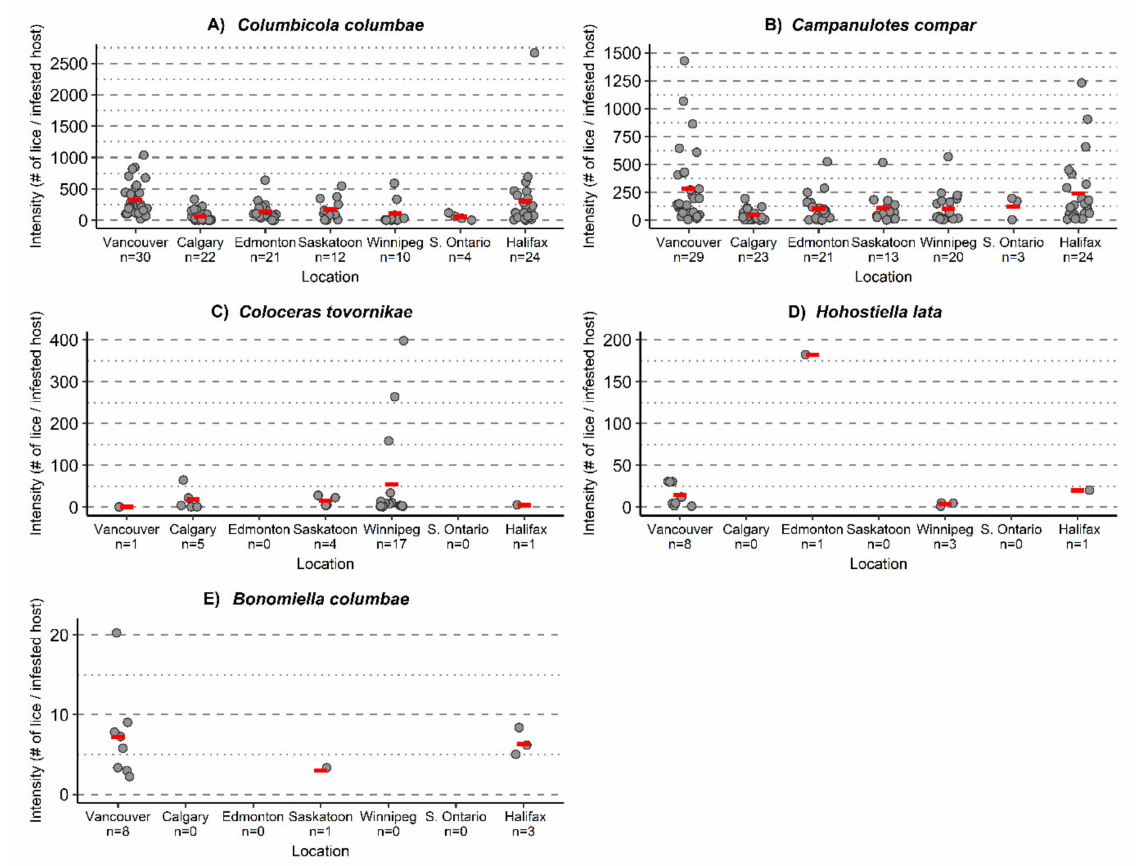
Figure 5. Mean intensity (red bar), each gray point represents the number of lice on an infested host. Feather lice: ( A ) Columbicola columbae , ( B ) Campanulotes compar , ( C ) Coloceras tovornikae , ( D ) Hohorstiella lata , and ( E ) Bonomiella columbae infesting Columba livia sampled from seven locations across Canada, 95% confidence intervals. Sample sizes refer to number of infested C. livia from each